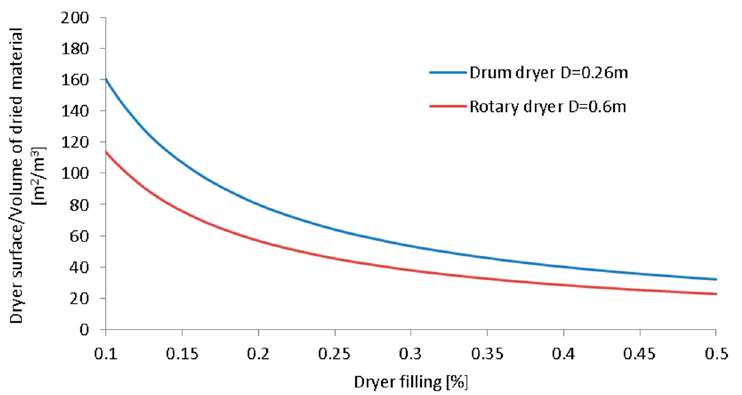
Figure 9. The ratio between the size of the dryer surface and the volume of the dried material for both tested dryers.